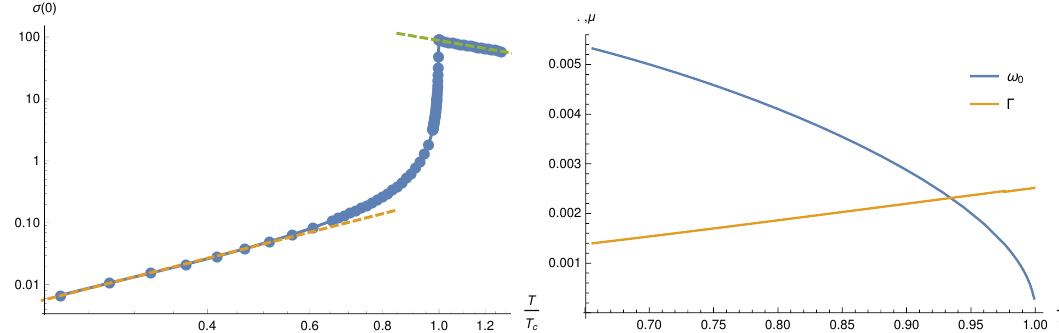
Figure 9 . Left panel: DC conductivity scaling at low and high temperatures across the phase transition. Right panel: relation between pinning frequency ( ! 0 ) and relaxation rate (cid:0).